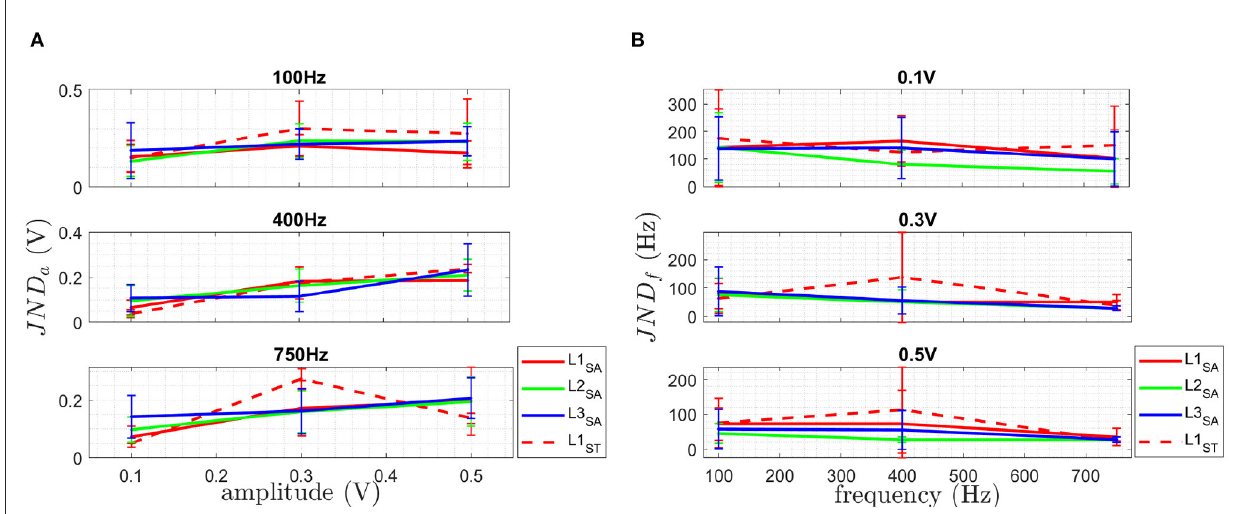
FIGURE5 The plot in (A) shows the detailed JND a at the three different chosen AF reference frequencies for the three different AF reference amplitudes and (B) shows the detailed JND f for at the three different chosen AF reference amplitudes for the three different AF reference frequencies. Both are given for the three sites L1-L3 for SA and ST . The mean is plotted as solid line and the standard deviation given as error bar.